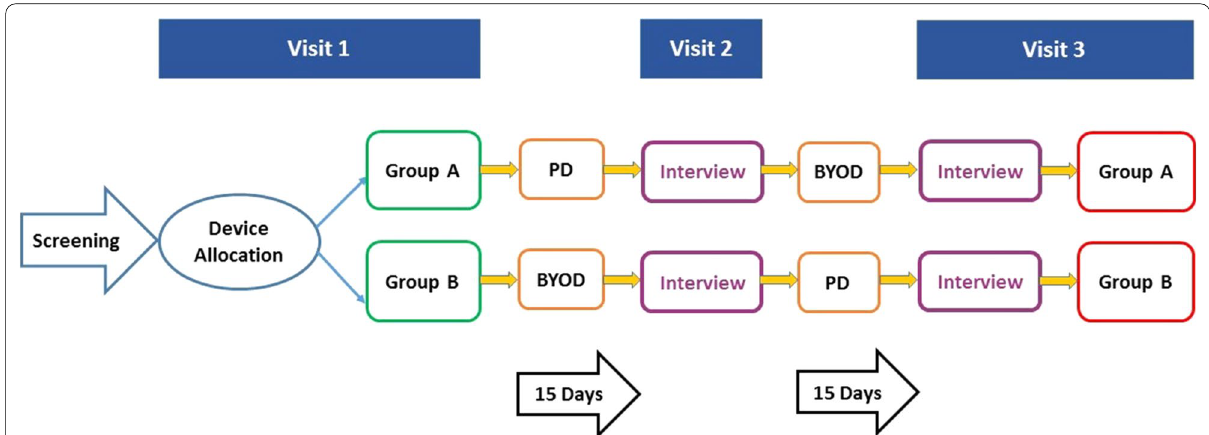
Fig. 1 Study design. Note The full study design included interviews with all study participants, and the interview results are reported elsewhere